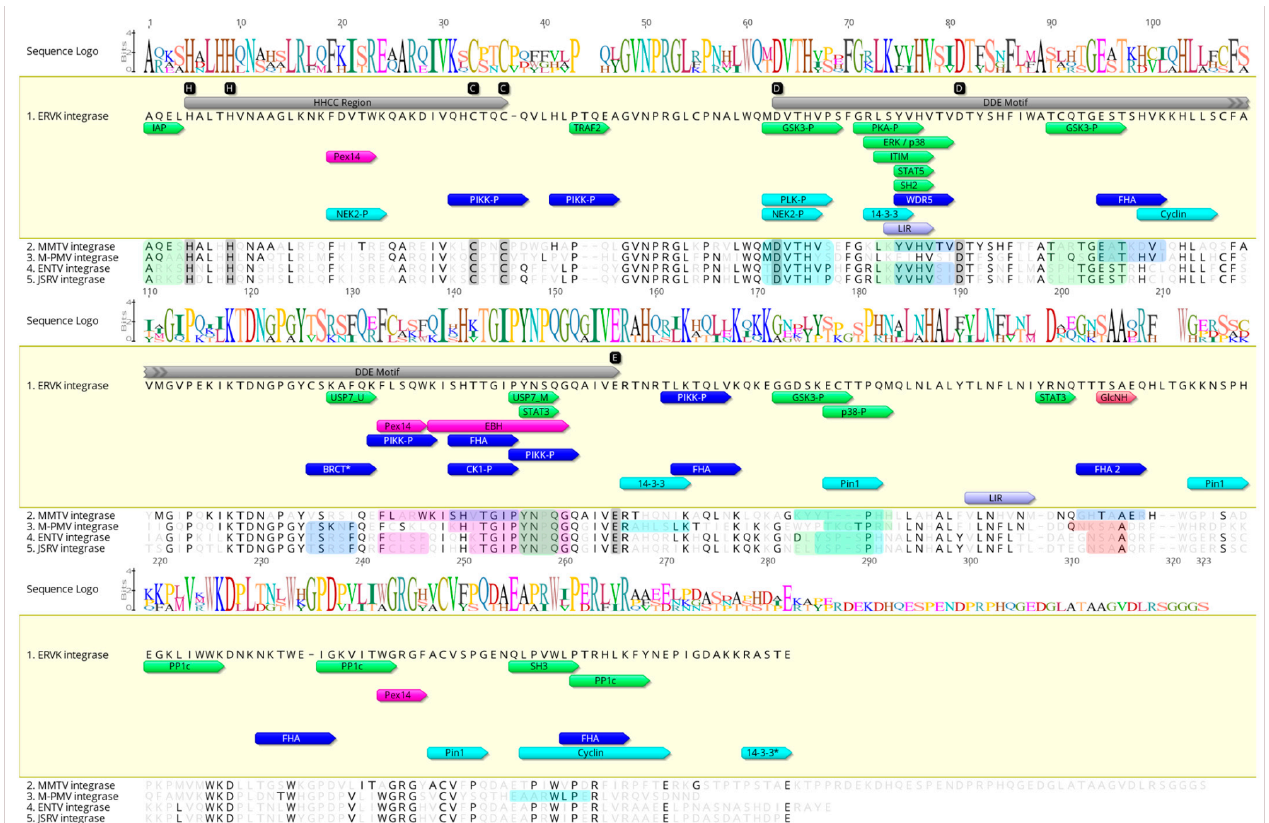
Figure 1. ERVK integrase and exogenous betaretrovirus integrases share common eukaryotic linear motifs. In silico examination of the conserved and differential eukaryotic linear motifs (ELMs) within Endogenous retrovirus-K (ERVK) and similar betaretroviral integrases. A betaretroviral integrase consensus sequence was constructed using GenBank